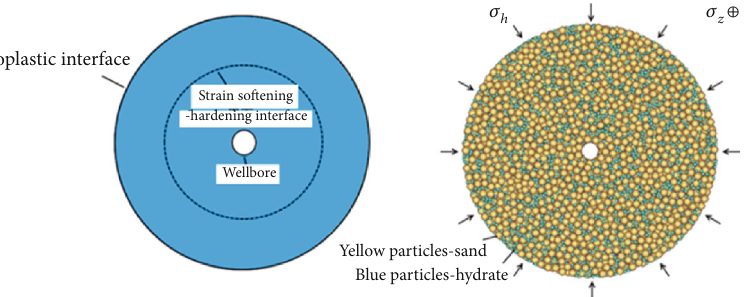
Figure 2: Schematic diagram of the analytical model (a) and the discrete element numerical model (b).